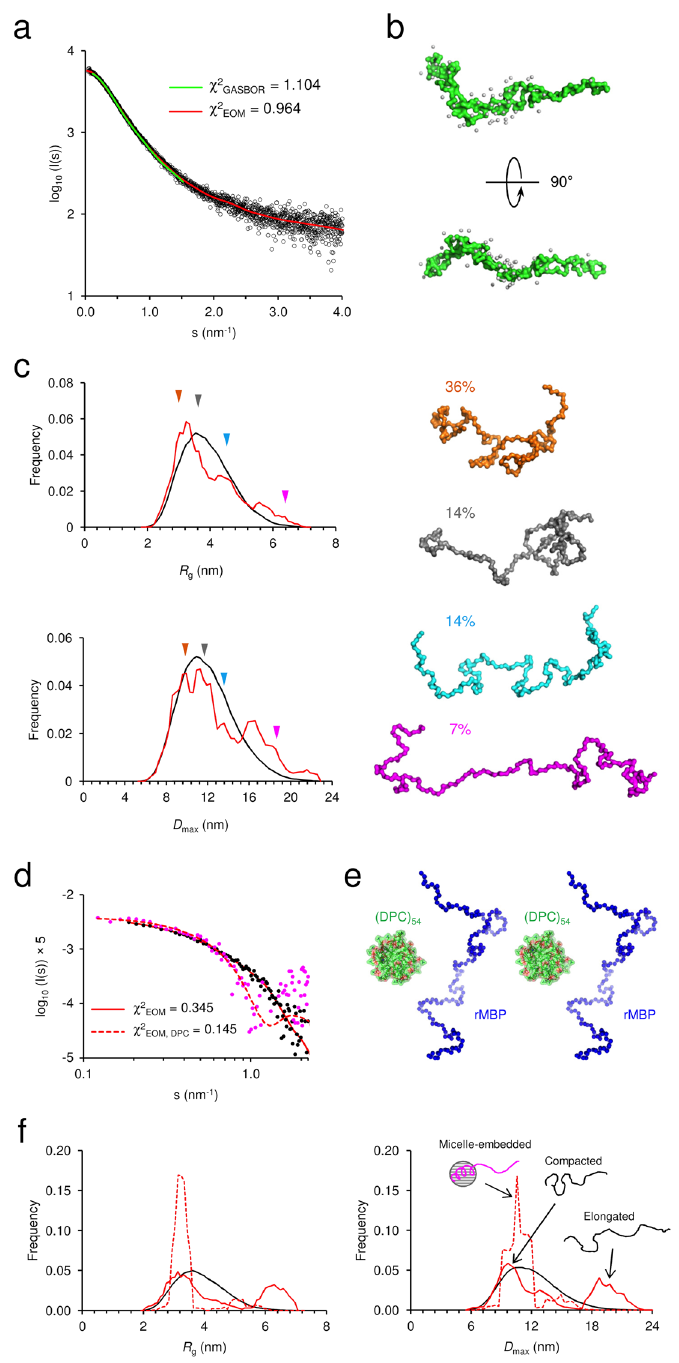
Figure 1. rMBP conformation in solution. ( a ) rMBP is significantly elongated based on SAXS data. GASBOR and EOM fits have been plotted over the raw data with their respective χ 2 values indicated. ( b ) The GASBOR ab initio model is elongated, with a maximum dimension around 12 nm. ( c ) EOM analysis of rMBP reveals wide R g and D max populations in an ensemble that represents the measured SAXS data. Selected models from EOM analysis (right) with their mass fractions within the total population are indicated. The coloured arrows denote the R g and D max of each model within the distributions. ( d ) SANS curves of rMBP in the absence and presence of DPC micelles (black and magenta, respectively). The EOM fits have been plotted over the data. ( e ) Stereoscopic image illustrating the size of an rMBP conformer and a DPC micelle of 54 detergent molecules 26 . ( f ) SANS EOM distributions of rMBP in the absence and presence of DPC micelles (solid and dashed lines, respectively). In the presence of DPC micelles (grey sphere), a distinct compacted population dominates (magenta cartoon) over the mixed elongated and compacted populations (black